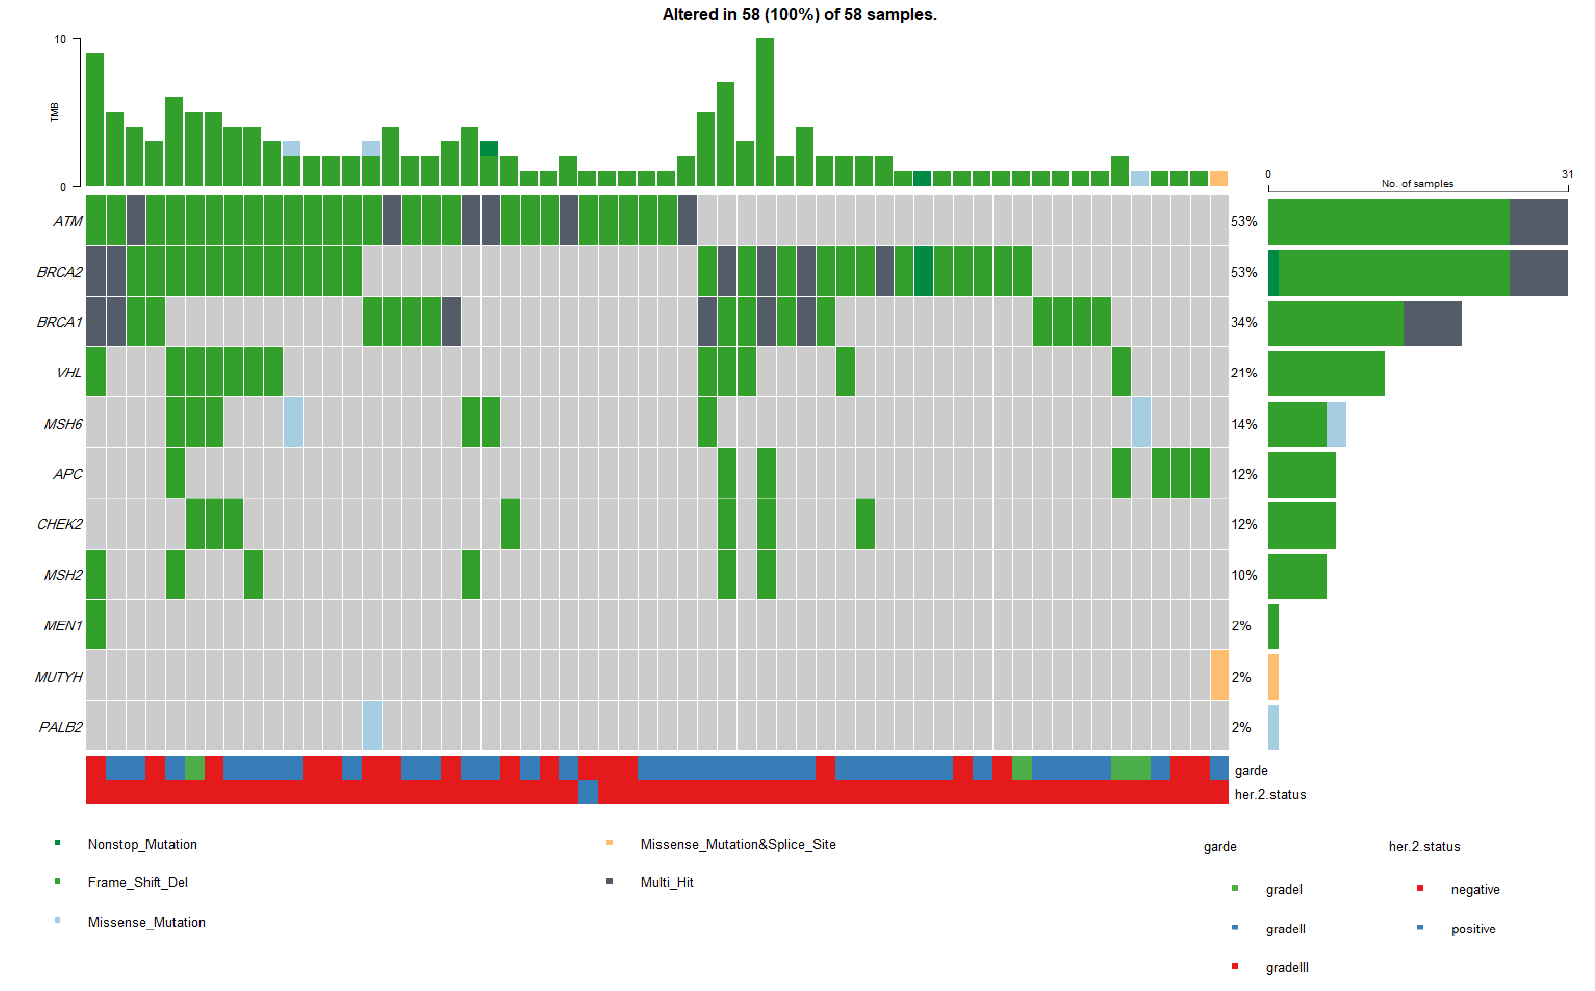
Figure 2. Oncoplot displays the pathogenic germline mutations identified in 58 patients out of 101.